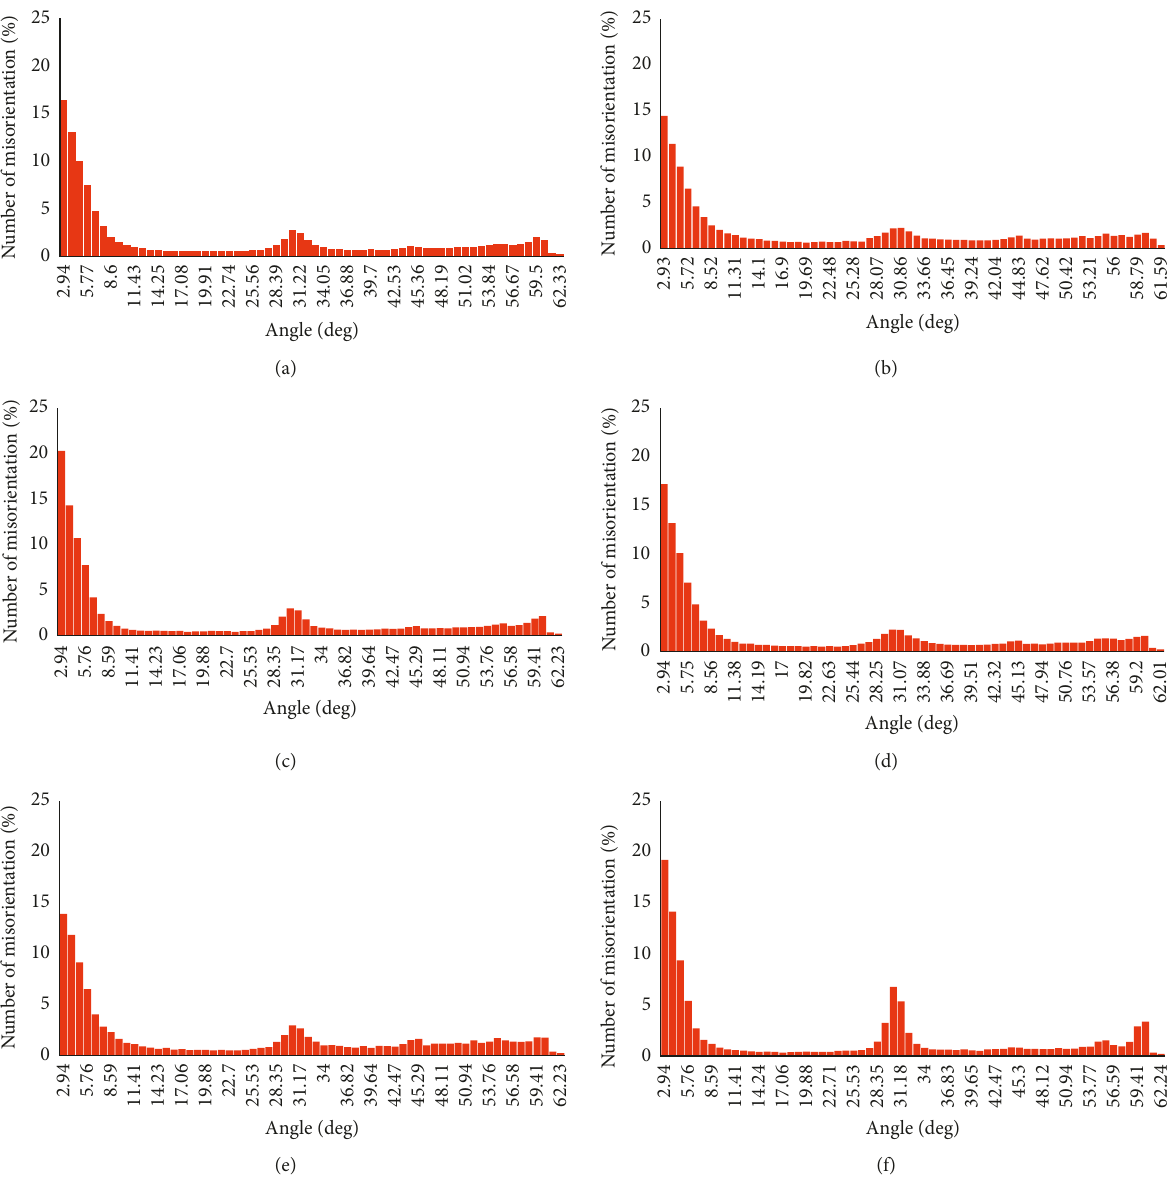
790 ° C, RR 30%, (b) RT 790 ° C, RR 60%, (c) RT 830 ° C, RR 30%, (cid:30) (cid:30) (cid:30) (cid:30) (cid:30) (cid:30) 870 ° C, RR 60%. (cid:30) (cid:30)